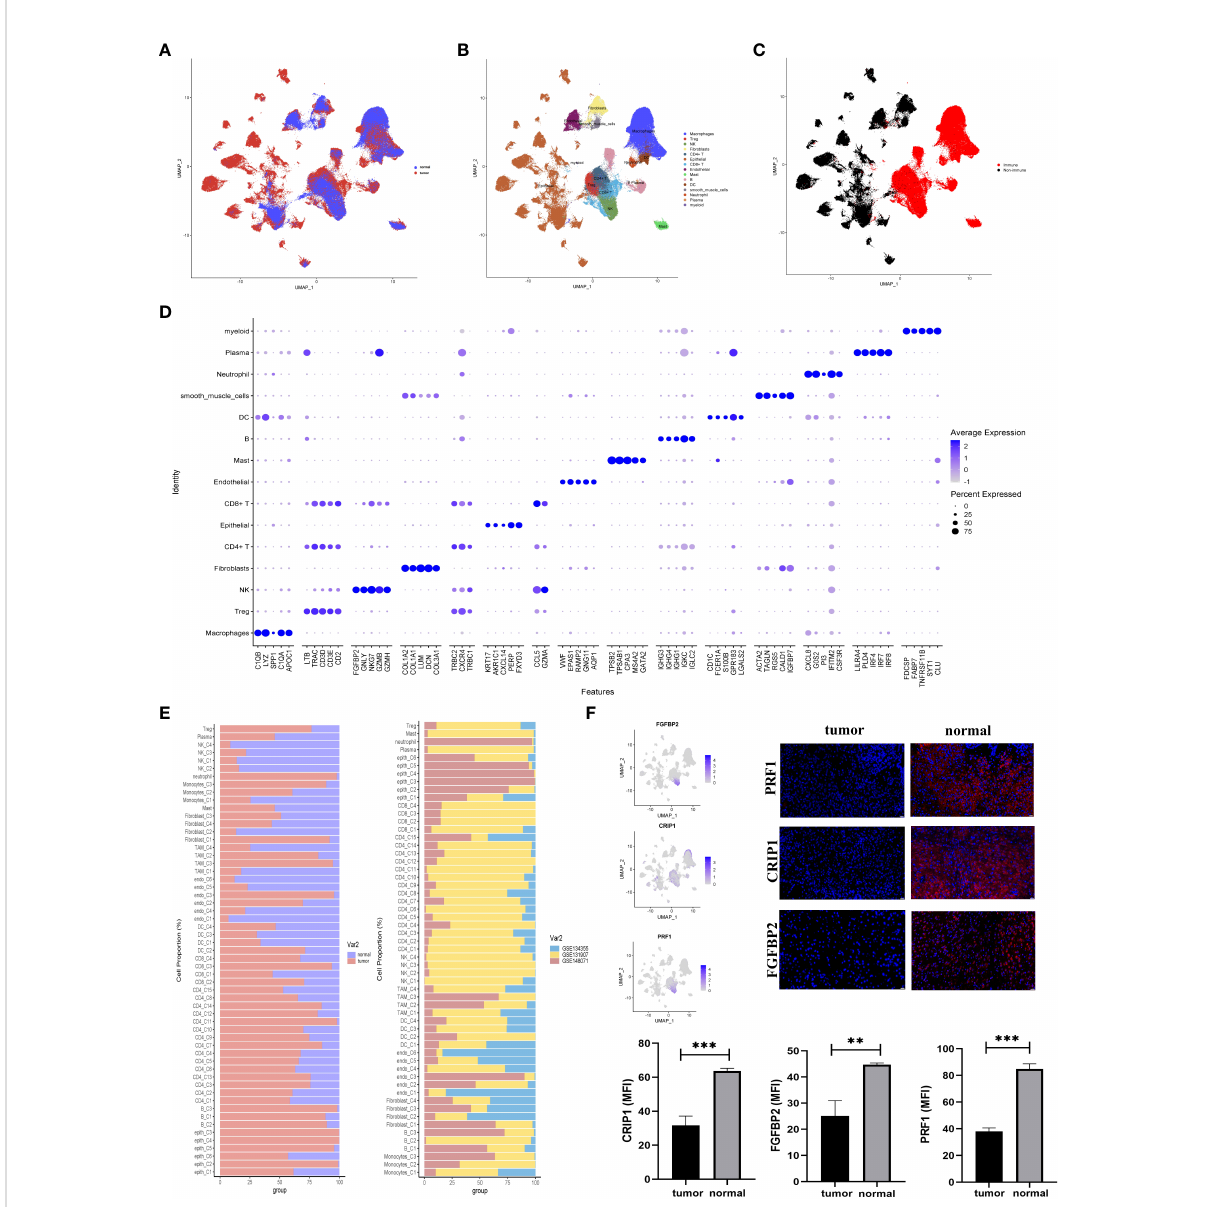
FIGURE 1 Comprehensive scRNA-seq analyses of cells derived from LUAD or normal tissues. (A – C) UMAP plot of single-cell transcriptome data with cells colored based on (A) tissue type origin (normal or tumor), (B) 15 major cell types, and (C) the immune cells or the non-immune cells. (D) The dot plot showed the top fi ve markers of 15 major cell types. (E) The 57 subsets were identi fi ed in this study: the relative proportion of cells derived from the normal or tumor specimens (left); and the relative proportion of cells derived from each of the three different datasets (right). (F) The expression status of three normal-speci fi c proteins, immuno fl uorescence and statistical analysis of RPF1, CRIP1, and FGFBP2 in tissue sections. The scale bar represented 20 µm, **p<0.01,